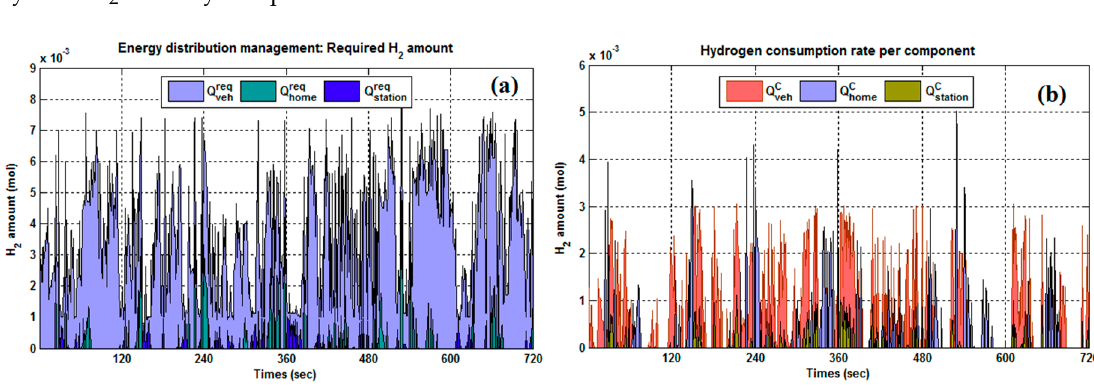
Figure 11. H 2 supply per component: ( a ) required amount and ( b ) delivery amount.